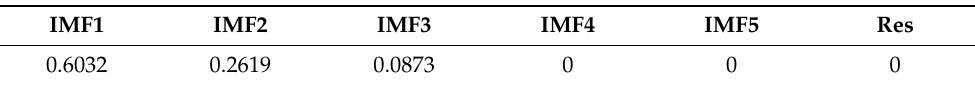
Table 5. The IMF zero-crossing rates for monthly load training and validation sets at the seasonal inflection